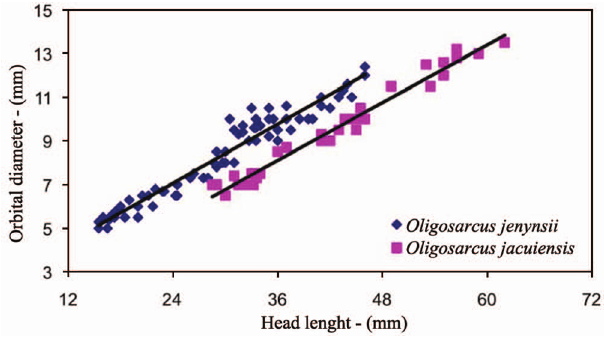
Fig. 4. Orbital diameter as a function of standard length for Oligosarcus jacuiensis , new species, and O . jenynsii .